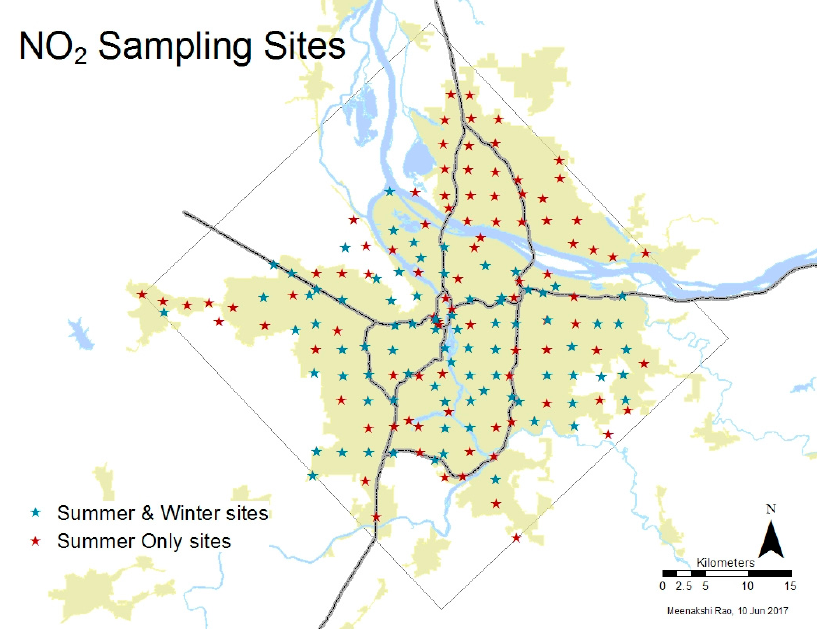
Figure 2. Summer and winter observation sites, with minimum bounding rectangle and urbanized area footprint. Blue stars represent sites monitored in summer and winter, red stars represent sites monitored in summer only.